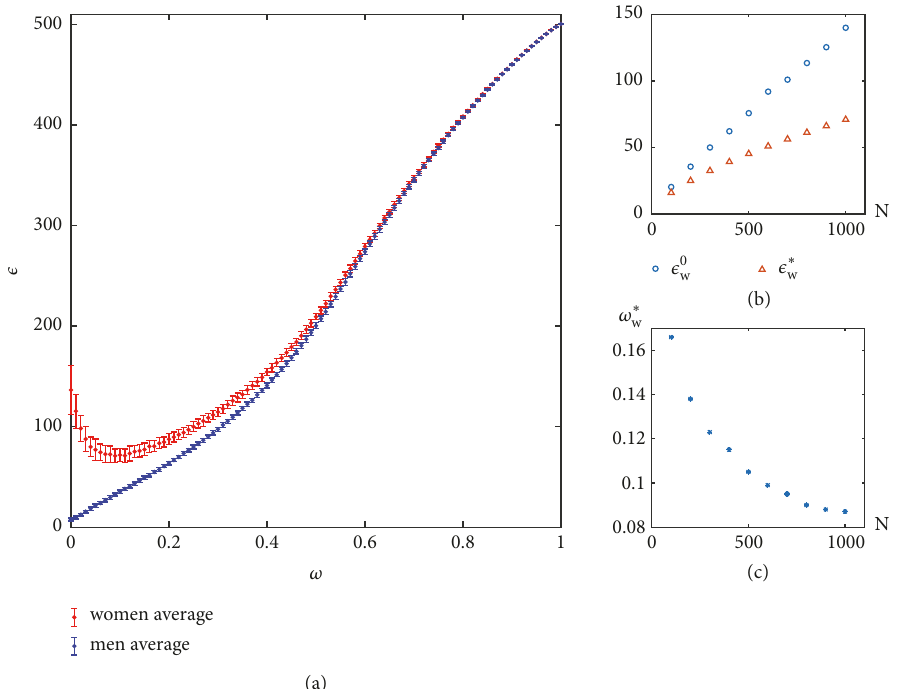
Figure 2: The numerical simulation of average ‘energy’ of men and women, 𝑁 = 1000 ; the result is averaged over 100 realizations. (a) The average‘energy’ of men and women, as a function of 𝜔 ; (b) for 𝑁 = 100,200,300, .. ., 1000 , the average‘energy’ of women at 𝜔 = 0 is denoted by 𝜖 0 𝑤 and at 𝜔 = 𝜔 ∗ 𝑤 is denoted by 𝜖 ∗ 𝑤 . Here 𝜔 ∗ 𝑤 is the women-optimal value of conformity weight; (c) the optimal weight 𝜔 ∗ 𝑤 versus 𝑁 .